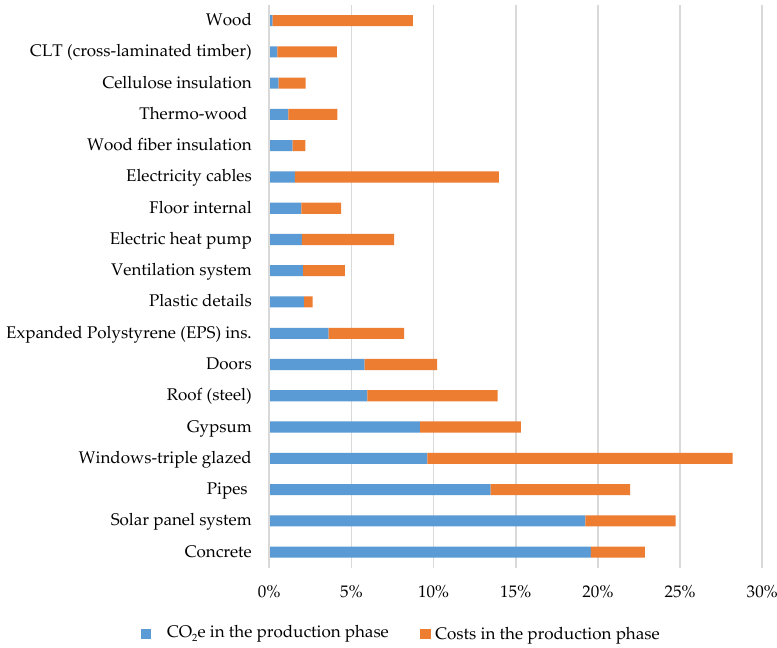
Figure 9. Production phase of building materials and installations: emissions vs. costs.